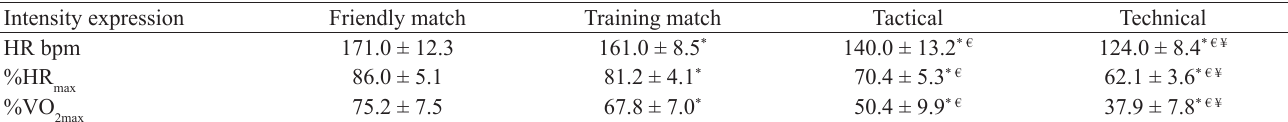
Table 1. Intensities of friendly match, training match, tactical training, and technical training, expressed as absolute heart rate (HR bpm), maximal heart rate percentage (%HR ) and maximal oxygen uptake percentage (%VO max